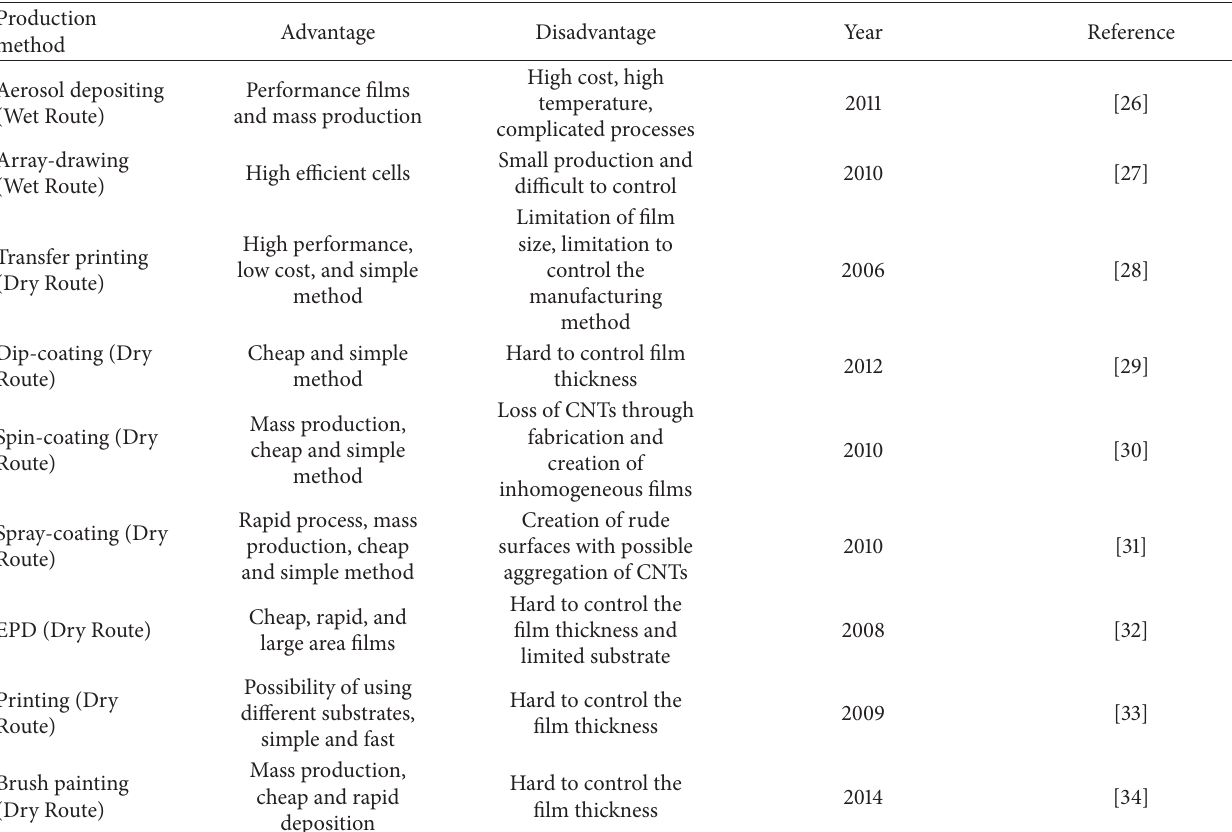
Table 1: Developments of different fabrication methods of